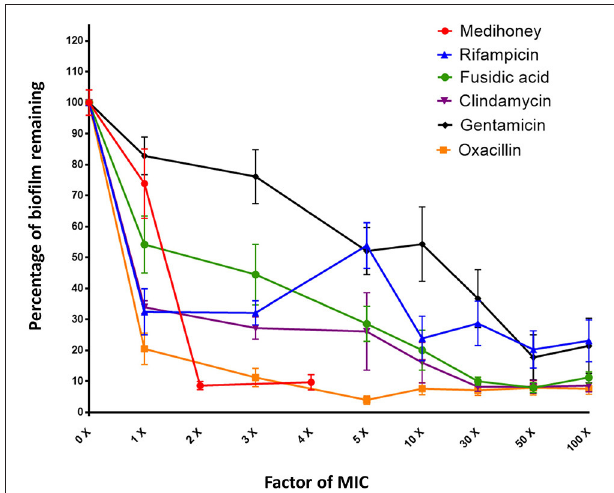
FIGURE 1 | Dose response curves for established S. aureus biofilms treated with Medihoney and antibiotics. Biofilms were established during 24h static incubation before treatment for 24h with either Medihoney or antibiotic at a range of concentrations. Biofilm biomass was then quantified using crystal violet staining. The biofilm remaining is expressed as a percentage relative to that of the untreated control, which is set at 100%. Error bars represent the standard error of the mean (SEM) of triplicate samples performed in duplicate on 3 different